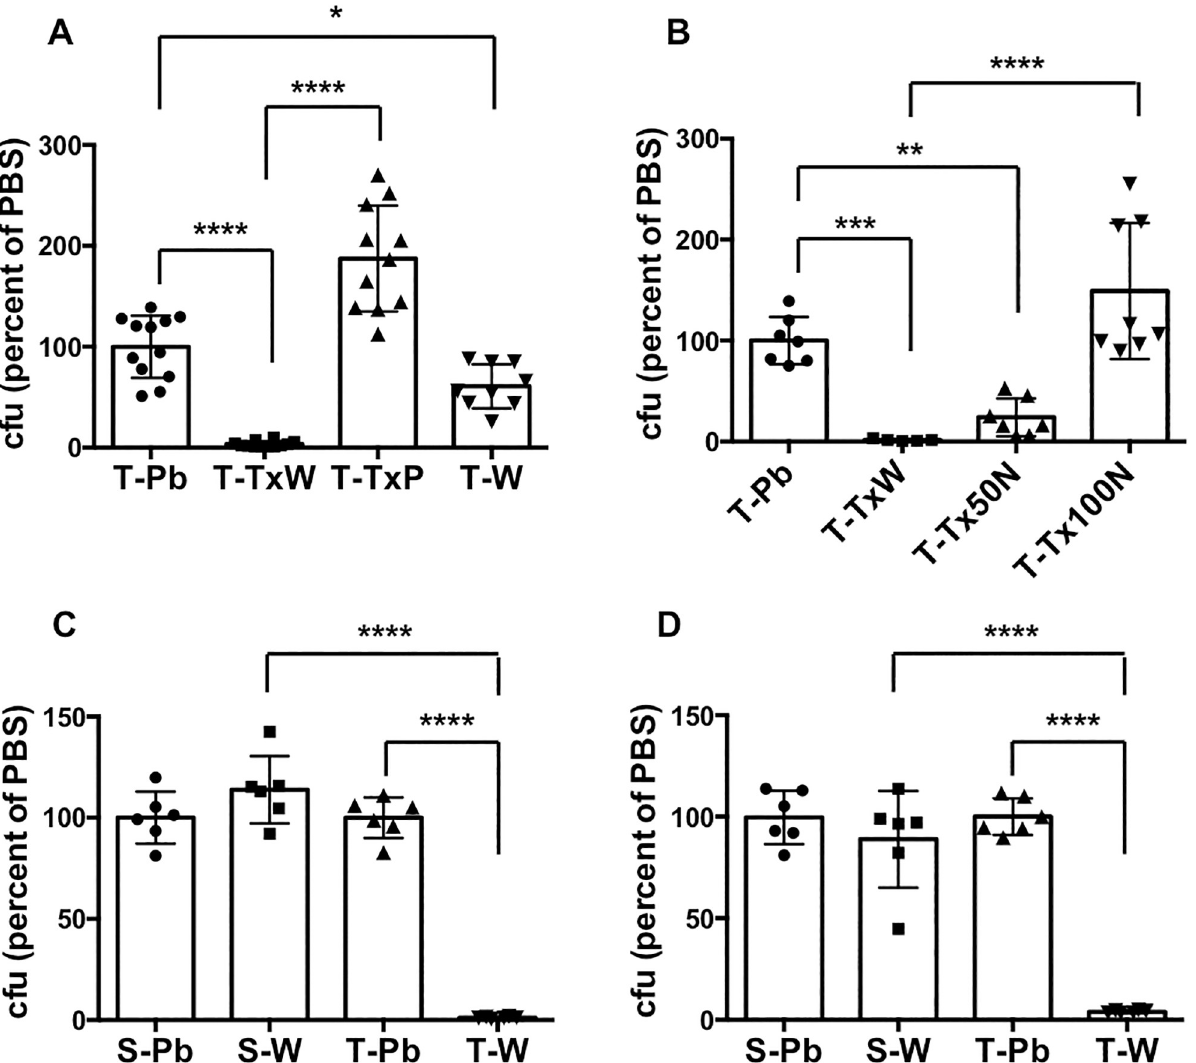
Fig 2. Hypotonic conditions are required for the effect of Triton X-100 on Ty2. A. Equivalent numbers of Ty2 (T), grown overnight in static culture, were incubated in PBS (Pb), in 1% Triton X-100 dissolved in either water (TxW) or PBS (TxP), or in sterile distilled water (W) for 1 hour on ice. The number of bacteria surviving in each condition was determined and expressed as a percentage of the number in PBS. � p = 0.0274, ���� p < 0.0001, n = 9–12 per group. B. Equivalent numbers of Ty2 (T) bacteria, grown overnight in static culture, were incubated in PBS (Pb), in 1% Triton X-100 in water (TxW), or in 1% Triton X-100 (Tx) in 50 or 100 mM NaCl (N) for 1 hour on ice. The number of bacteria surviving in each condition was determined and expressed as a percentage of the number in PBS. �� p = 0.0089, ��� p = 0.0018, ���� p < 0.0001, n = 5–8 per group. C. Equivalent numbers of SL1344 (S) or Ty2 (T) bacteria, grown overnight in shaking cultures, were incubated in PBS (Pb) or sterile distilled water (W) for 1 hour on ice. The number of bacteria surviving in each condition was determined and expressed as a percentage of the number in PBS for each strain. ���� p < 0.0001, n = 6 per group. D. Equivalent numbers of SL1344 (S) or Ty2 (T) bacteria, grown overnight in shaking cultures, were incubated in PBS (Pb) or sterile distilled water (W) for 1 hour at 37˚C. The number of bacteria surviving in each condition was determined and expressed as a percentage of the number in PBS for each strain. ���� p < 0.0001, n = 6 per